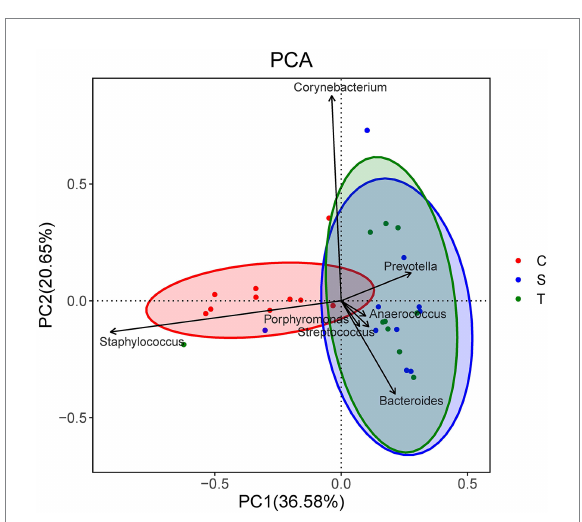
FIGURE 3 Principal component analysis (PCA) of the three groups. Samples that are more similar to each other should appear closer together along the corresponding axis reflecting the variation among all samples. Coordinates for the genera arrows are correlations with each axis, and only the seven most important (based on the magnitude of correlations) genera are shown.